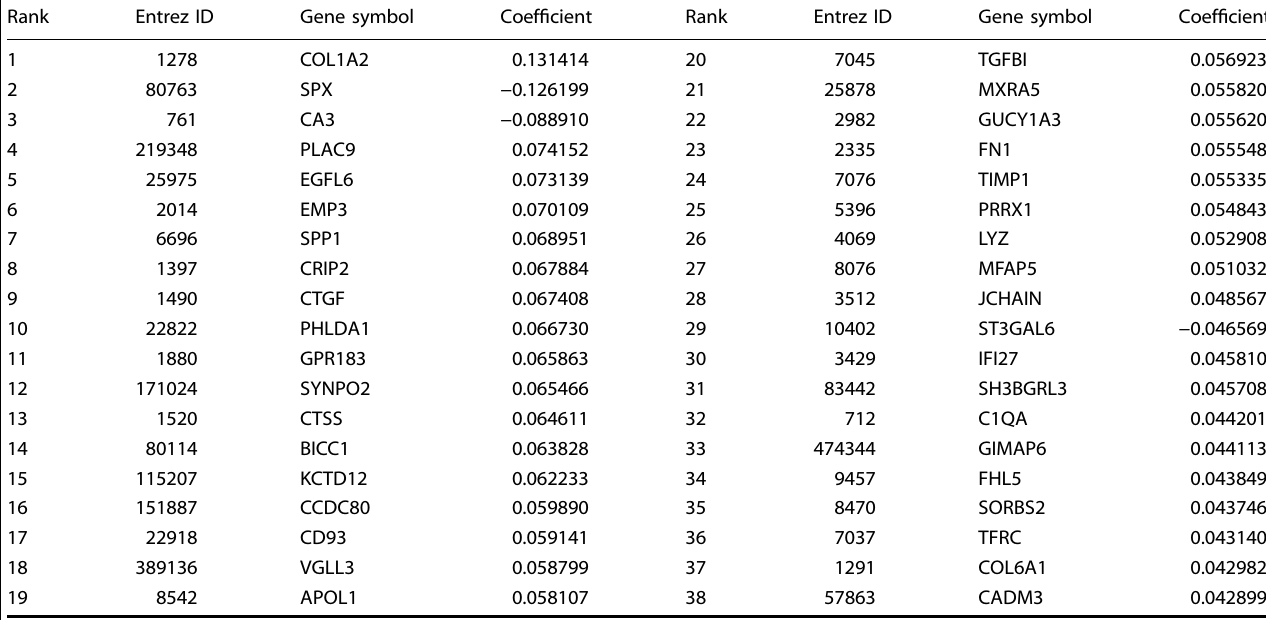
Table 1. The 38 genes in the obesity score, and their associated coef fi